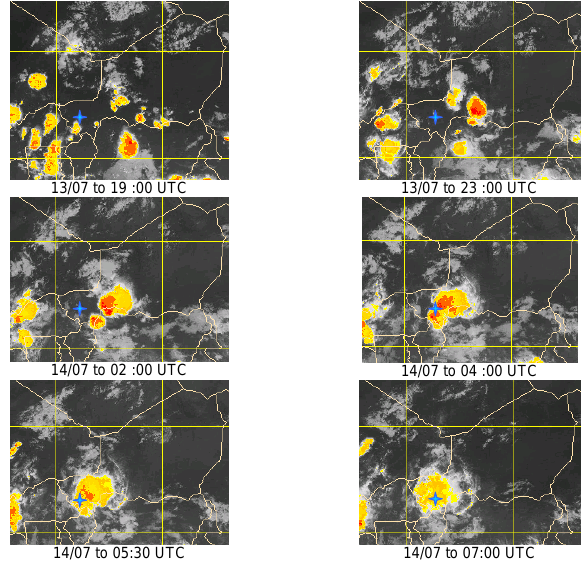
Fig. 1. Meteosat images from convective system developing for the Figure 1: Meteosat images from convective system developing for the 14/07/06, the Banizoumbou 14 July 2006, the Banizoumbou station is marked by a blue star. station is marked by a blue star.